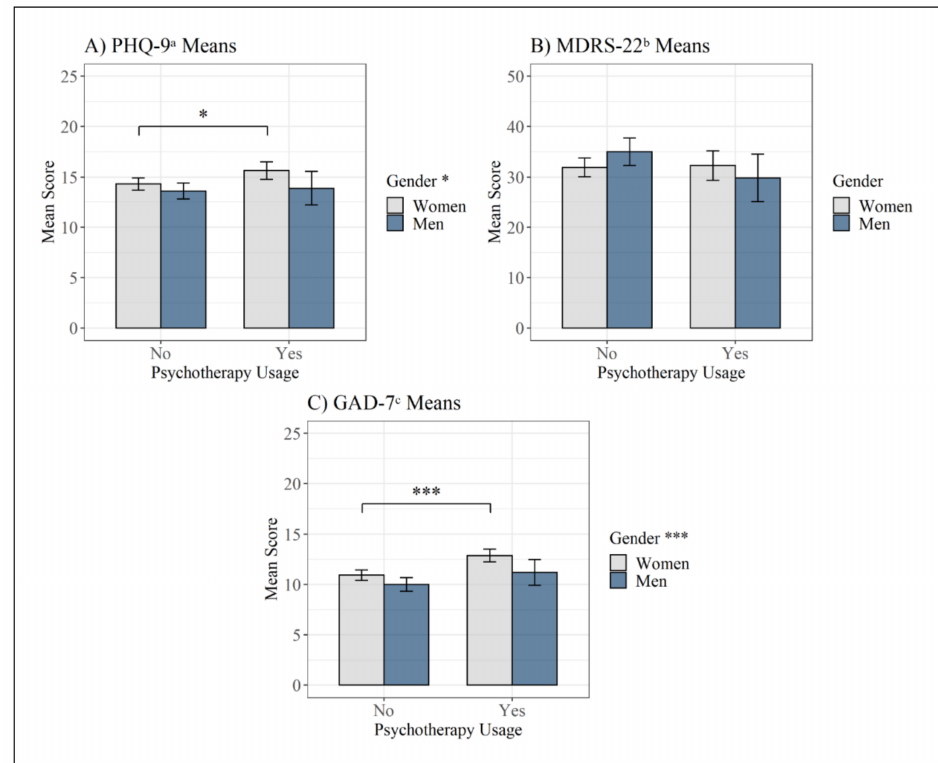
Figure 2. Mean scores on the depression and anxiety questionnaires in the different subgroups with a 95% confidence interval. ( A ) PHQ-9 a Means; ( B ) MDRS-22 b Means; ( C ) GAD-7 c Means. Note: asterisks in the legend indicate significant gender differences regardless of psychotherapy use. a PHQ-9 = Patient Health Questionnaire-9; b MDRS-22 = Male Depression Risk Scale-22;